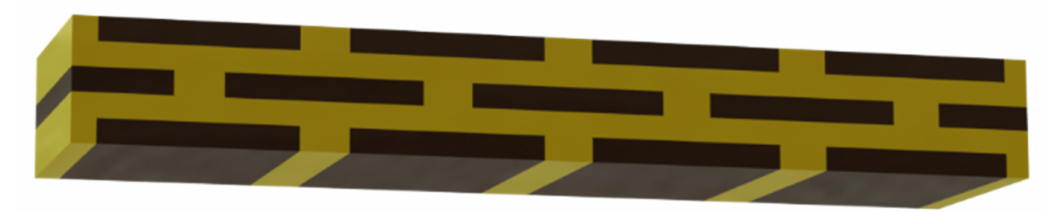
Figure 19. CAD drawing of a 4D component: brick wall-like test